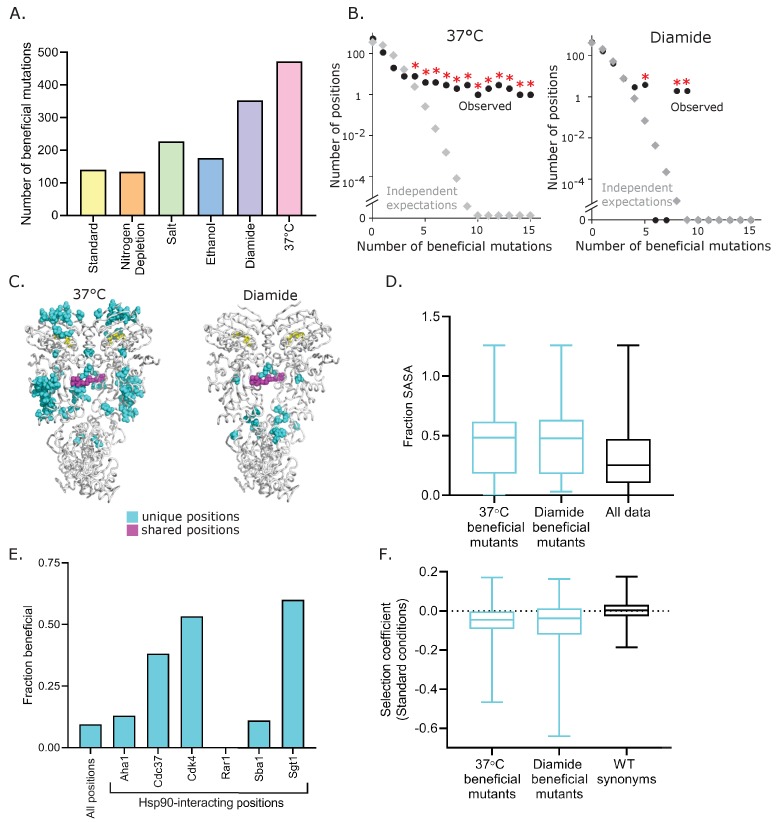
Beneficial variants in diamide and elevated temperature conditions.(A) Number of beneficial mutations identified in each condition based on selection coefficients more than two standard deviations greater than wild-type synonyms. Beneficial mutants at 37°C and in diamide are listed in Figure 5—source data 1. (B) Distribution of the number of beneficial mutations at the same position in both 37°C (left) and diamide (right) conditions (●) is greater than expected if they had occurred independently (◊). Independent expectations were calculated as the probability of the stated number of mutations occurring at the same position by chance. * Indicates observations that were significantly (p<0.01) greater than independent expectations based on random simulations and one-tailed t-tests. (C) Location of positions with four or more beneficial mutations. Positions that are unique to diamide or 37°C are shown in cyan and two shared positions are shown in magenta. (D) The solvent accessible surface area (SASA) of beneficial mutations at 37°C and in diamide compared to all mutations. Distributions are significantly different as measured by a two-sample KS test (37°C vs. all data, N = 270, 12393, p<0.0001, D = 0.2851; Diamide vs. all data, N = 60,12393, p<0.0001, D = 0.3465) (E) The fraction of Hsp90 positions at interfaces that were beneficial in 37°C and diamide conditions. (F) Selection coefficients in standard conditions for beneficial mutations at 37°C and in diamide compared to wild-type synonyms. (KS test; 37°C vs. WT synonyms: N = 463, 660, p<0.0001, D = 0.3281; Diamide vs. WT synonyms: N = 353, 660, p<0.0001, D = 0.3809).Figure 5—source data 1.List of all beneficial mutants and associated selection coefficients at 37°C and in diamide.Beneficial mutants were defined as variants with selection coefficients two standard deviations greater than wild-type synonyms.